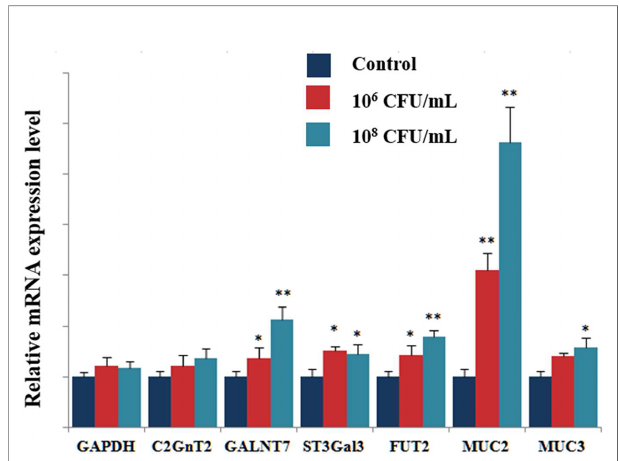
FIGURE 5 | Effects of C. butyricum on the mRNA expression of GTs and mucins. RT-qPCR analysis was performed to determine the mRNA expression levels of GTs and mucins. Results are expressed as fold increase in GTs and Muc compared to untreated cell and normalized using GAPDH mRNA. Results are expressed as means and standard deviation of three independent experiments with ** P < 0.01 and * P <